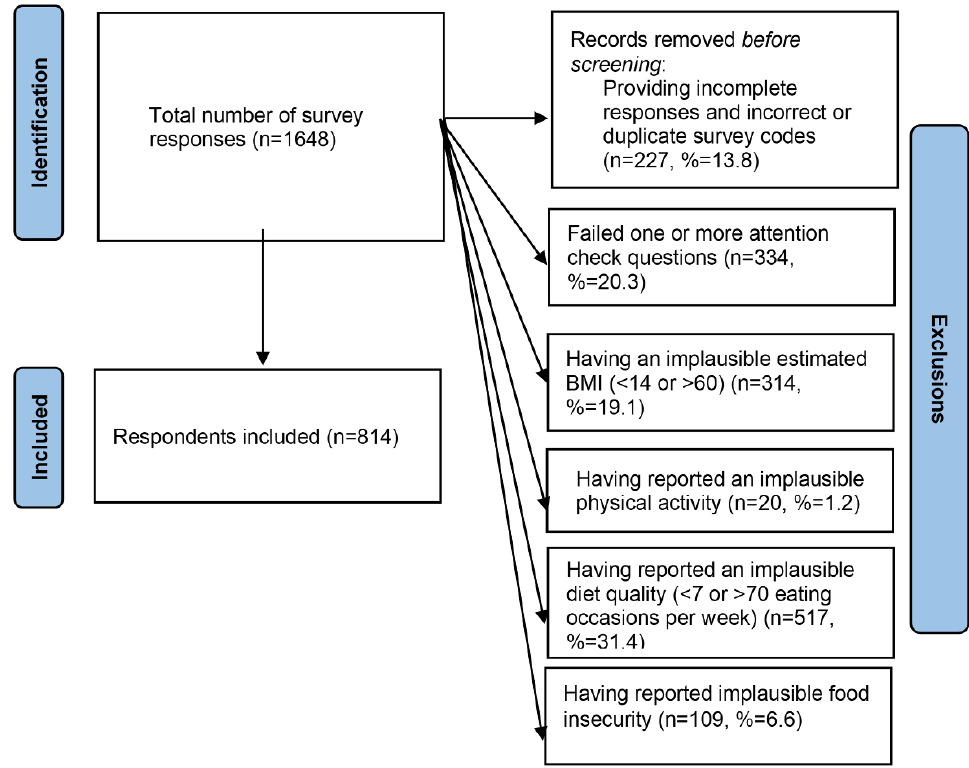
Figure 1. Flow of respondents and exclusions. Several responses met multiple exclusion criteria, thus the sum of exclusions exceeds 834.